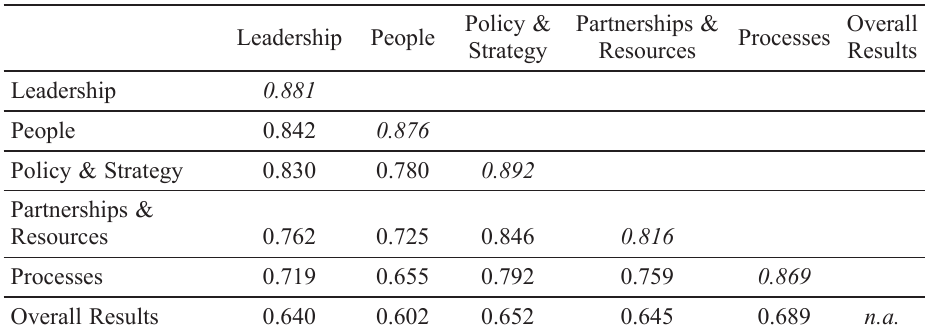
Table 3. Discriminant